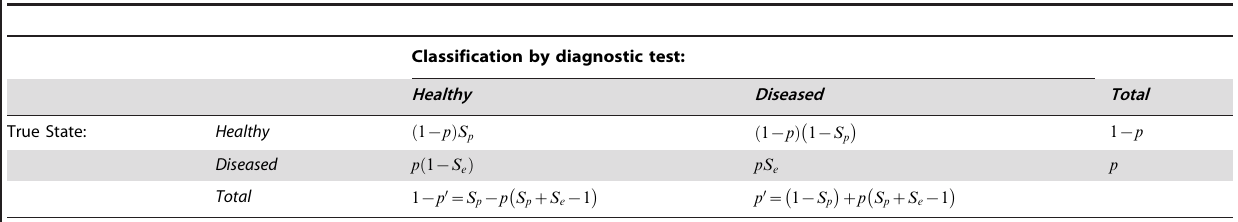
Table 1. Proportions of individuals classified as Healthy or Diseased, as a function of Specificity (S p ) or Sensitivity (S e ).